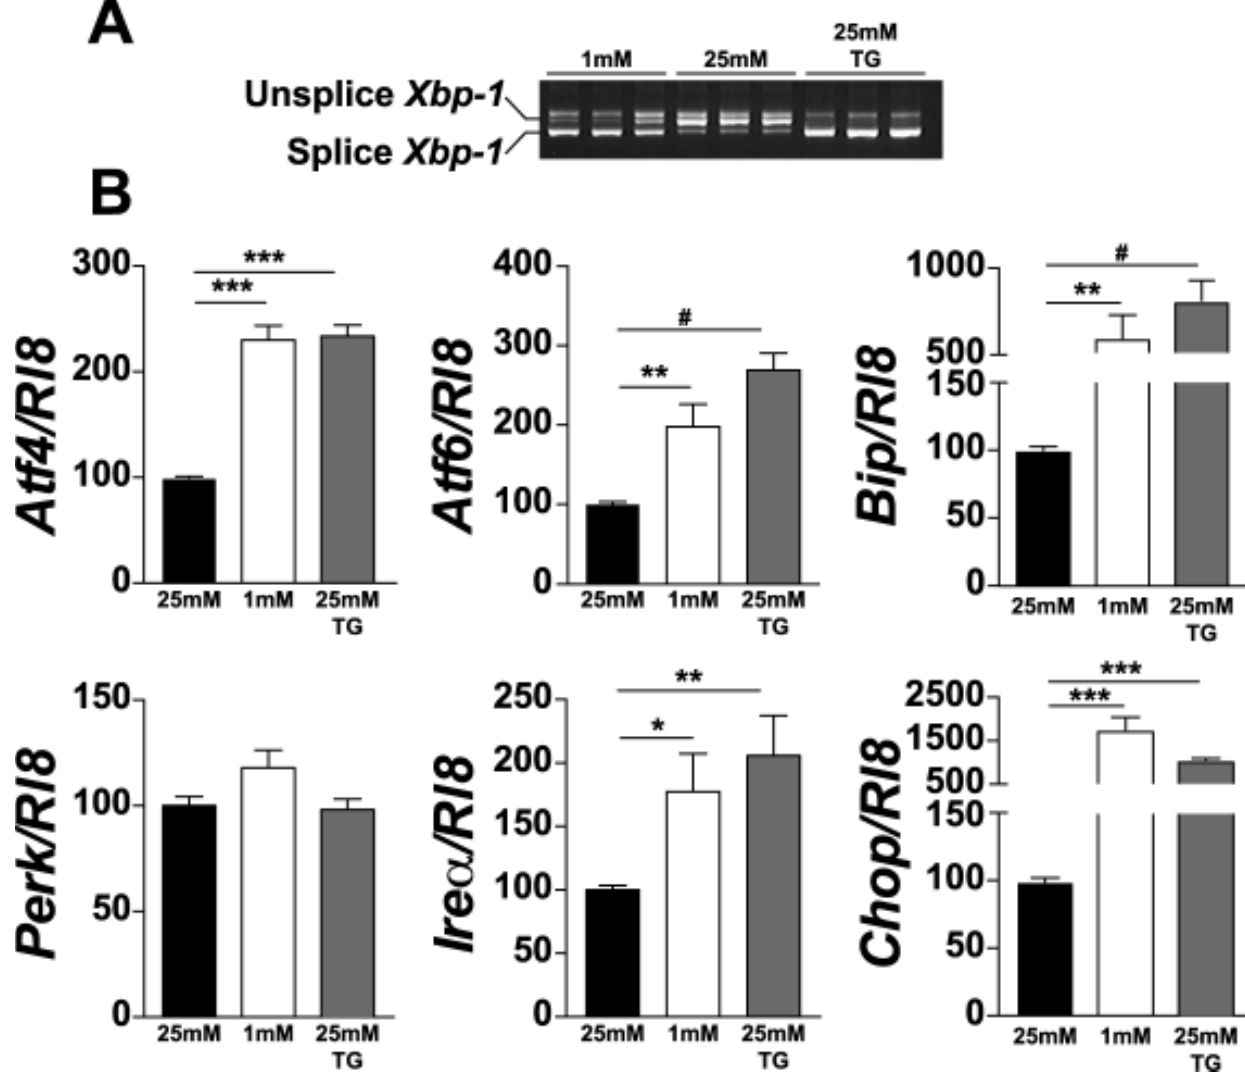
Figure 1. Low glucose condition increases Xbp-1 mRNA splicing and expression of ER stress genes in 661W cells. After treatment of 661W photoreceptor cells with ER-stress activators, Xbp-1 mRNA splicing was evaluated by PCR ( A ). UPR-associated gene expression was evaluated by qPCR, normalised with Rl8 expression ( B ). Results are expressed as mean ± SEM of three experiments ( n = 7; * p < 0.05, ** p < 0.005, *** p < 0.0001, # p <